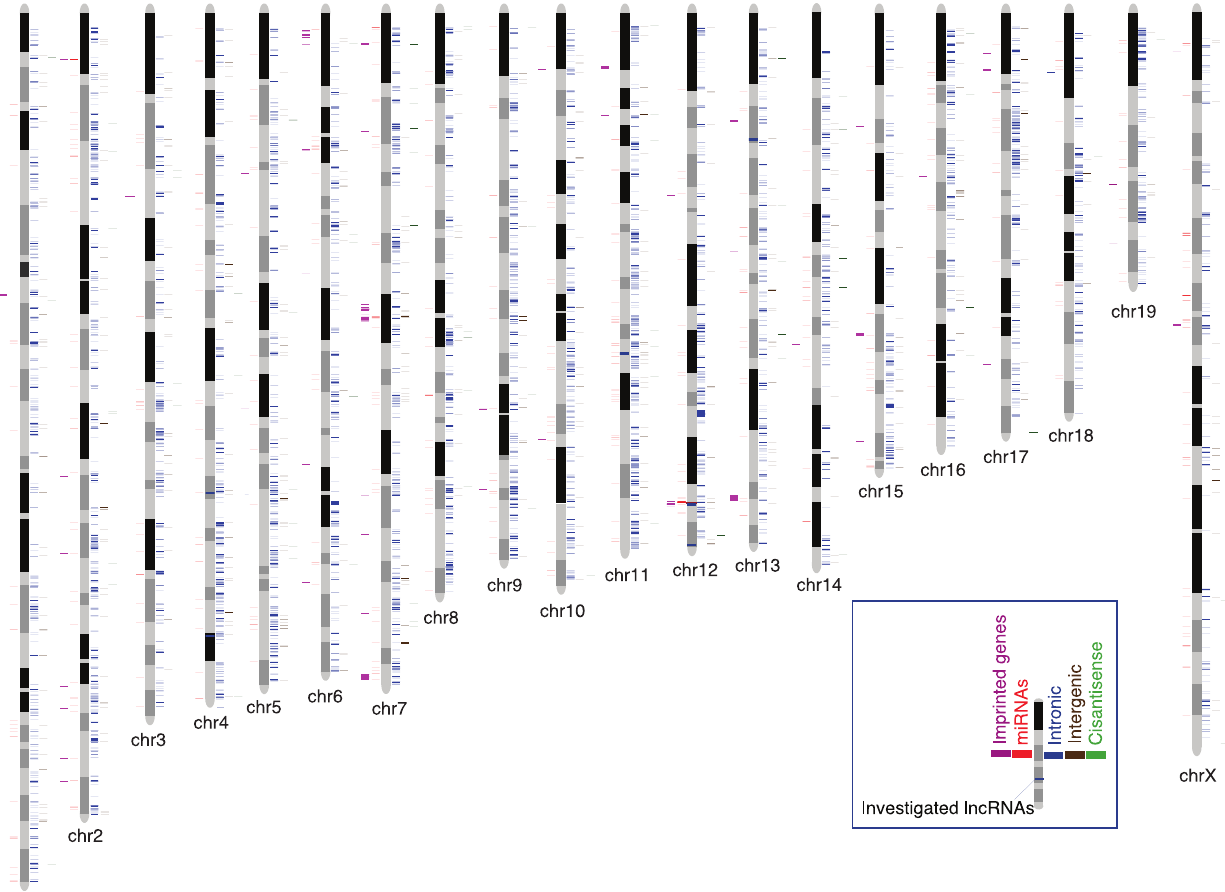
Figure 4. Chromosomal distribution of lncRNAs in the mouse genome. For each chromosome, the annotations shown from left to right are: Imprinted genes, miRNAs, intronic lncRNAs, intergenic lncRNAs and cis-antisense lncRNAs. For each chromosome, the chromosomal coordinates start from top (0) to bottom. Six lncRNA candidates investigated by RT-PCR with four developmental time points are marked by blue horizontal bars overlaid on chromosomes, while genomic details are in Table S3.